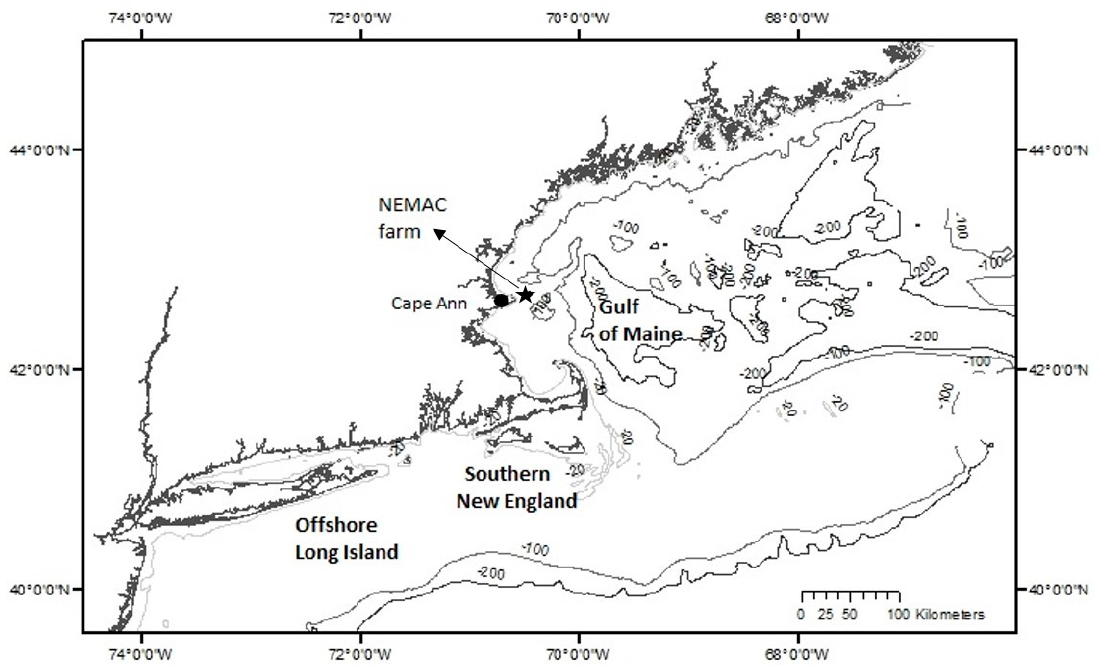
Figure 2. Inner shelf of the northeast area of the United States, including areas offshore Long Island, Rhode Island, Massachusetts and New Hampshire and detail of bathymetric contours (20 m, 100 m, 200 m depth). The star symbol locates the Northeast Massachusetts Aquaculture Center (NEMAC) experimental farming site, offshore Cape Ann.